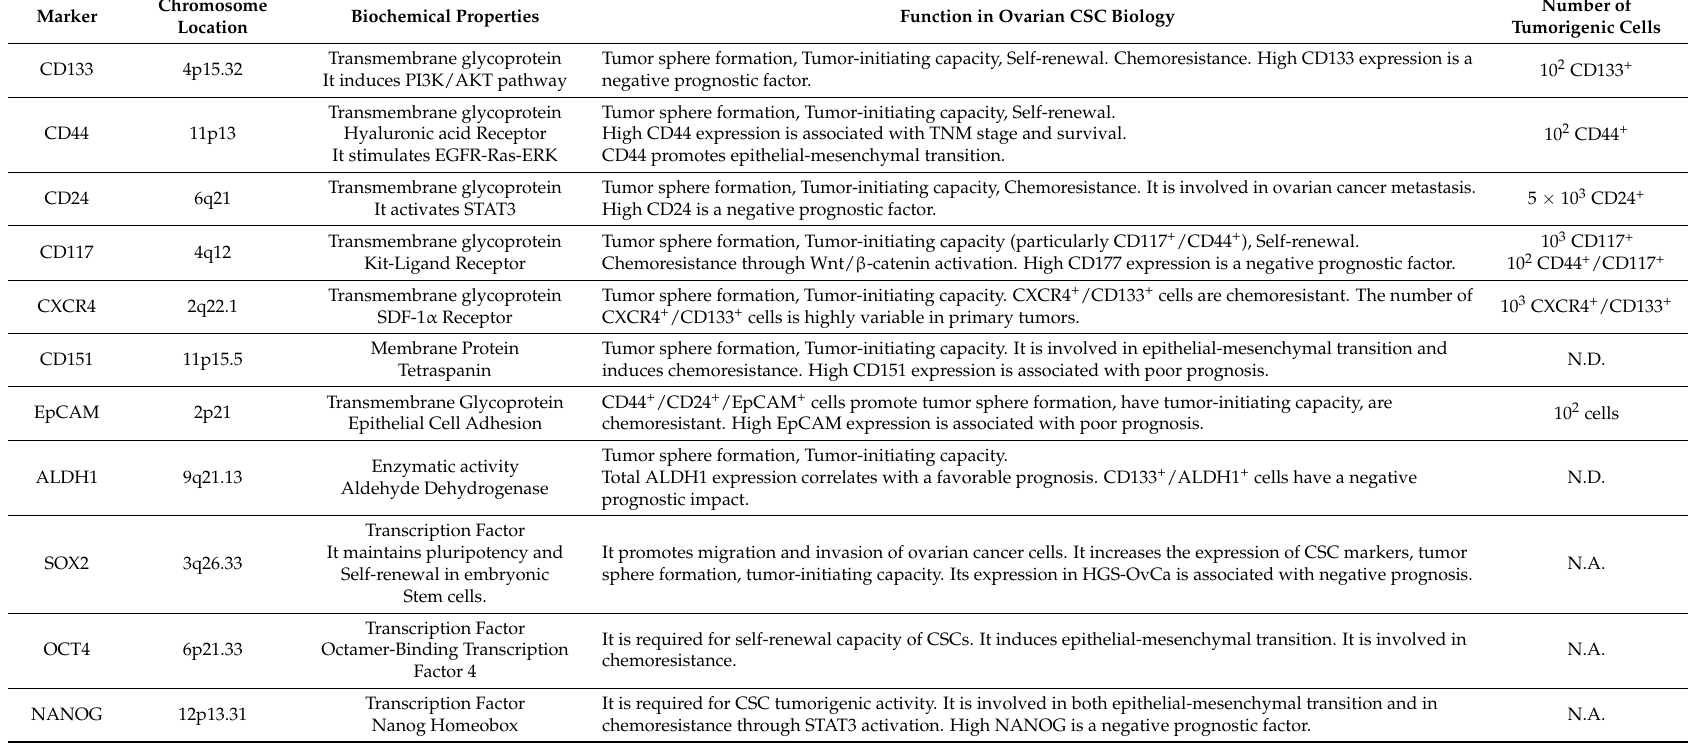
Table 4. Main properties of markers of ovarian cancer stem